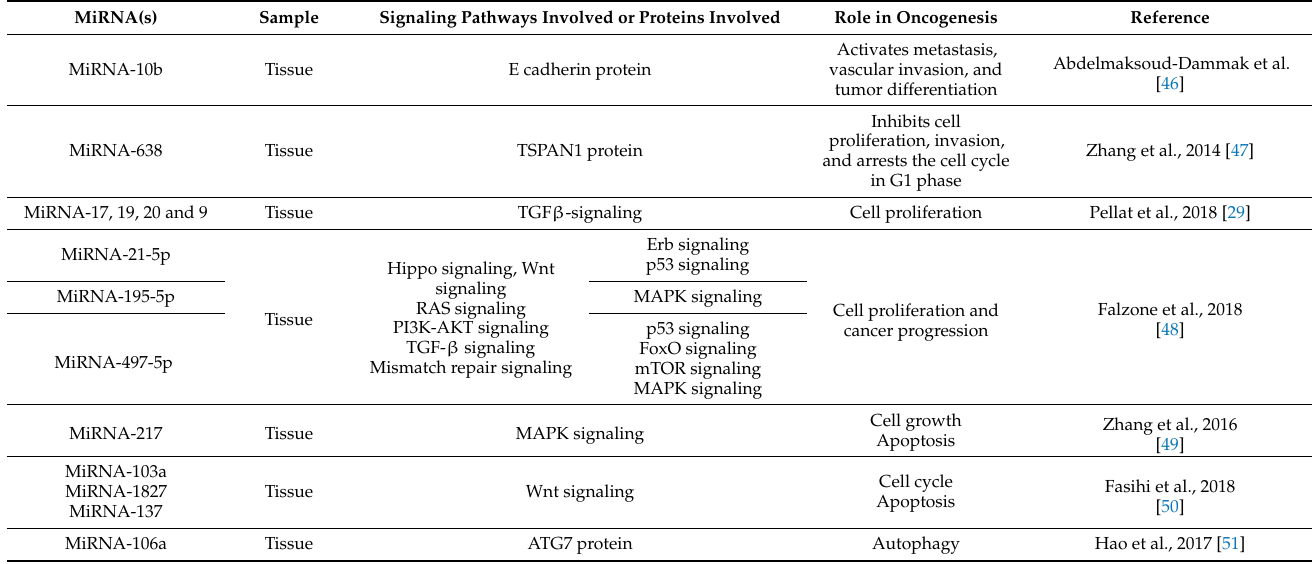
Table 1. MiRNAs and CRC